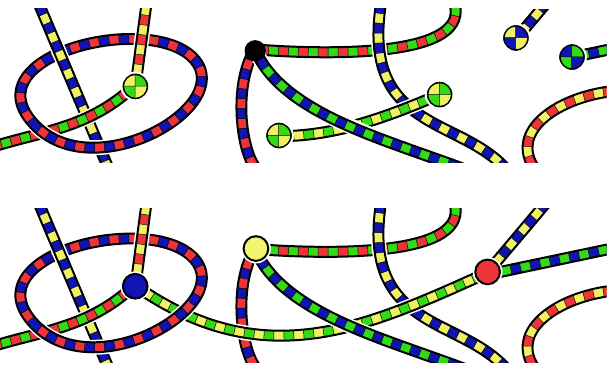
FIG. 3. Two stages in the extraction of the error syndrome. (Top) The measurements of the gauge generators provides a noisy gauge syndrome that does not satisfy color flux conservation at the points marked with a two-colored circle. The branching point marked in black satisfies flux conservation. (Bottom) The gauge syndrome is corrected by adding suitable edges. The error syndrome is the set of branching points of the net of fluxes, marked here as colored circles.